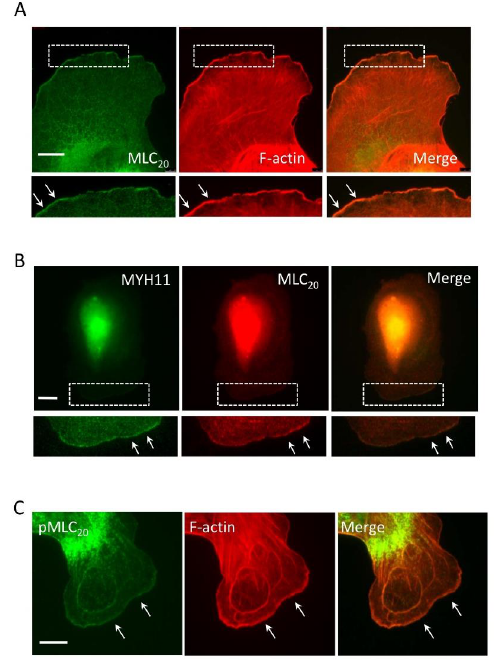
Figure 1. Smooth muscle myosin localizes at the tip of lamellipodia. ( A ) Human airway smooth muscle (HASM) cells were plated onto collagen-coated coverslips for 30 min and stained for 20-kDa myosin light chain (MLC 20 ) and F-actin. MLC 20 is found at the leading cell edge. In addition, F-actin is also localized at the cell edge. ( B ) Myosin-11 (MYH11) colocalizes with MLC 20 at the leading edge. ( C ) Phosphorylated MLC 20 (pMLC 20 ) is found to position at the leading edge. The arrows point to the leading edge. Scale bar: 10 µm.